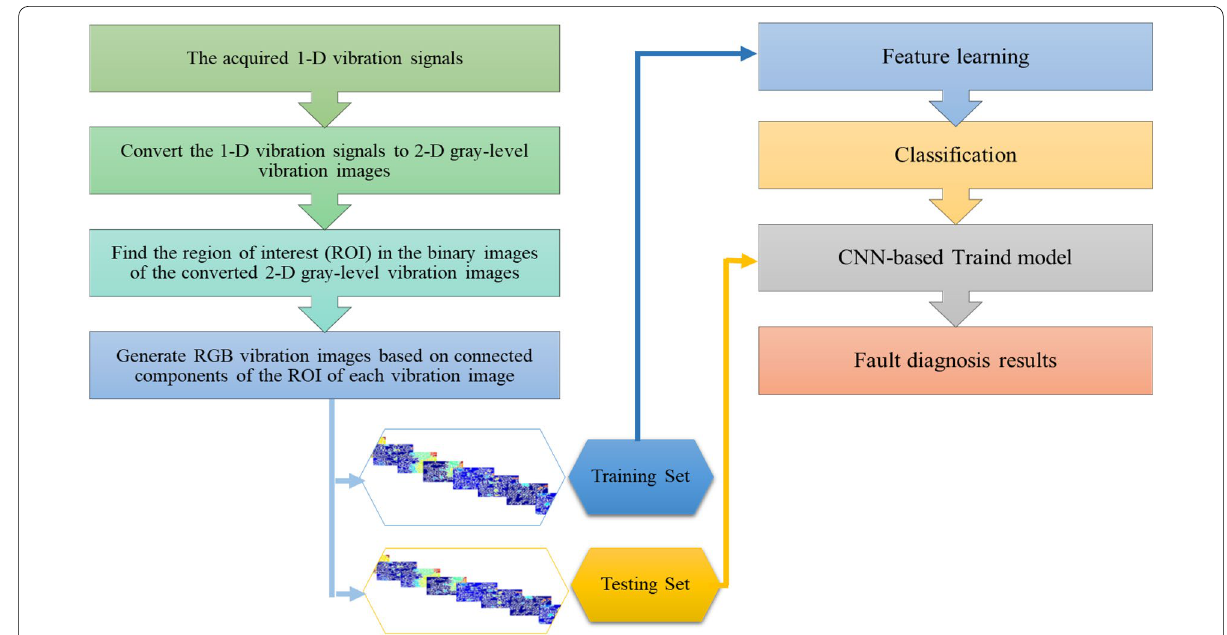
Figure 1 The proposed